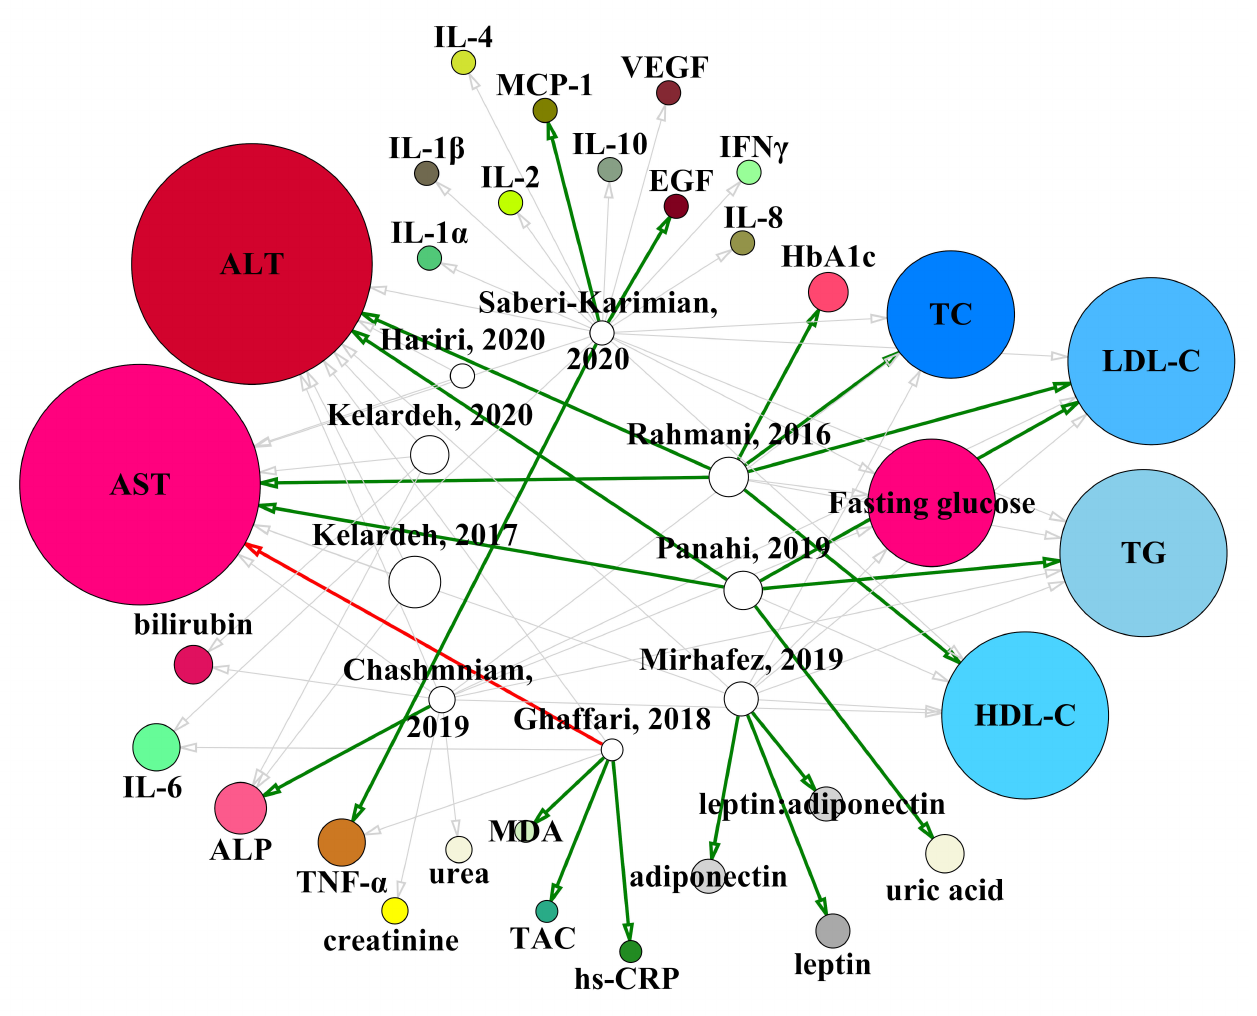
Figure 2. Network graph on effects of curcumin supplementation in